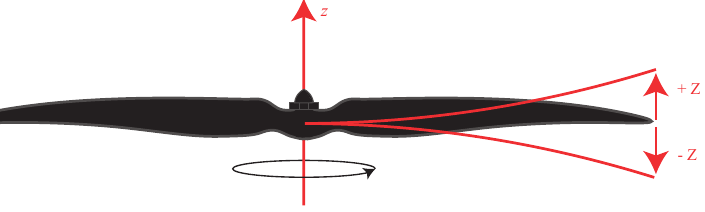
Figure 2. Propeller displacement due to vibration.